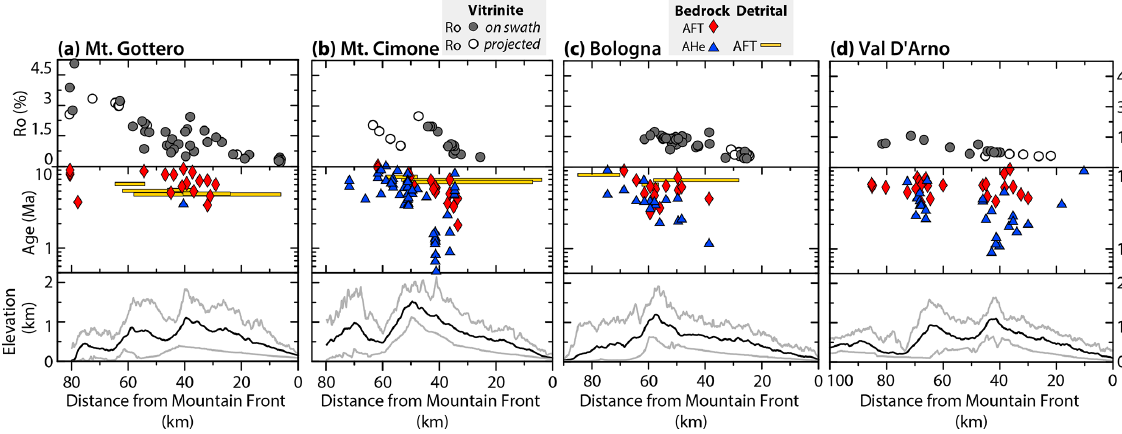
Figure 2. Published vitrinite reflectance (Botti et al., 2004; Carlini et al., 2013; Reutter et al., 1983; Ventura et al., 2001), published bedrock cooling ages (Abbate et al., 1994; Balestrieri, 2000; Balestrieri et al., 1996, 2018; Bonini et al., 2013; Carlini et al., 2013; Fellin et al., 2007; Thomson et al., 2010; Ventura et al., 2001; Zattin et al., 2002) and new detrital cooling ages, and topography plotted along (a) Mt. Gottero, (b) Mt. Cimone, (c) Bologna, and (b) Val D’Arno swath profiles. Profile locations are shown in Fig. 3a. Top row: filled circles are vitrinite reflectance samples located within the 30km wide swath profile; empty circles are located outside of swath profile line and were projected onto the line. Middle row: cooling ages corrected for topography for bedrock AFT (red diamonds), and AHe (blue triangles). Detrital AFT samples (yellow rectangles) were not corrected for topography. Bottom row: mean elevation (thick black line) and minimum and maximum elevation (light grey